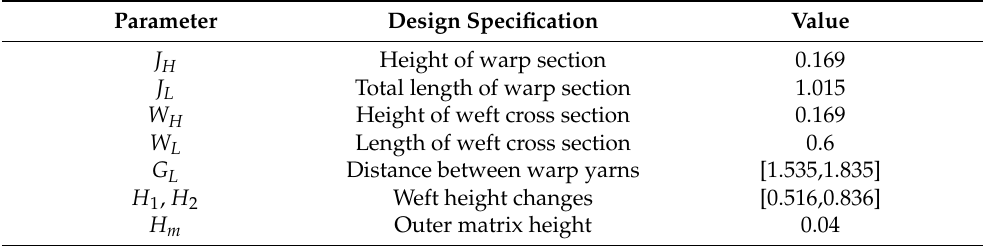
Table 9. The geometric design parameters of uncertainty model.